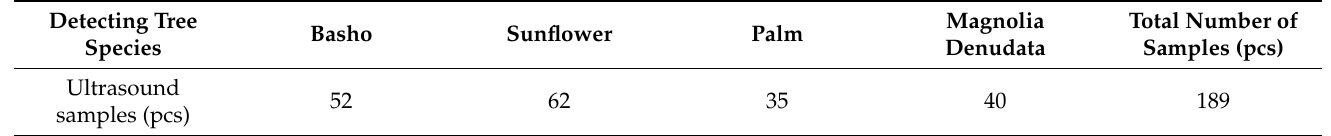
Table 8. Sample number of radial features of stems of four species.